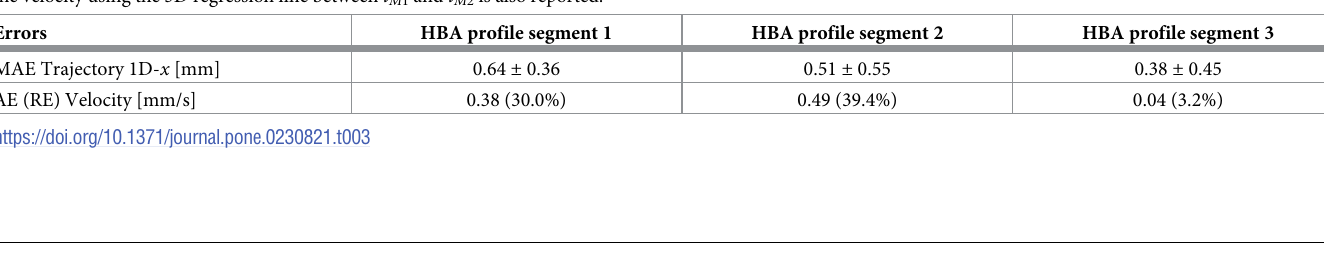
The envelopes of all volume reconstructions show deviations compared to the ground-truth volume. The stenosis lengths are highlighted with red arrows. The MT reconstruction method leads to stenosis lengths and relative positions that are almost equal to the ground-truth vol- ume for all motion profiles. The IP reconstruction method shows a larger deviation of the ste- nosis relative position. Furthermore, an obvious deviation of the depicted stenosis length using the IP volume reconstruction method are depicted for the BA and HBA profiles. Espe- cially, for the BA profile with underlying deceleration of the catheter, the length is obviously increased.